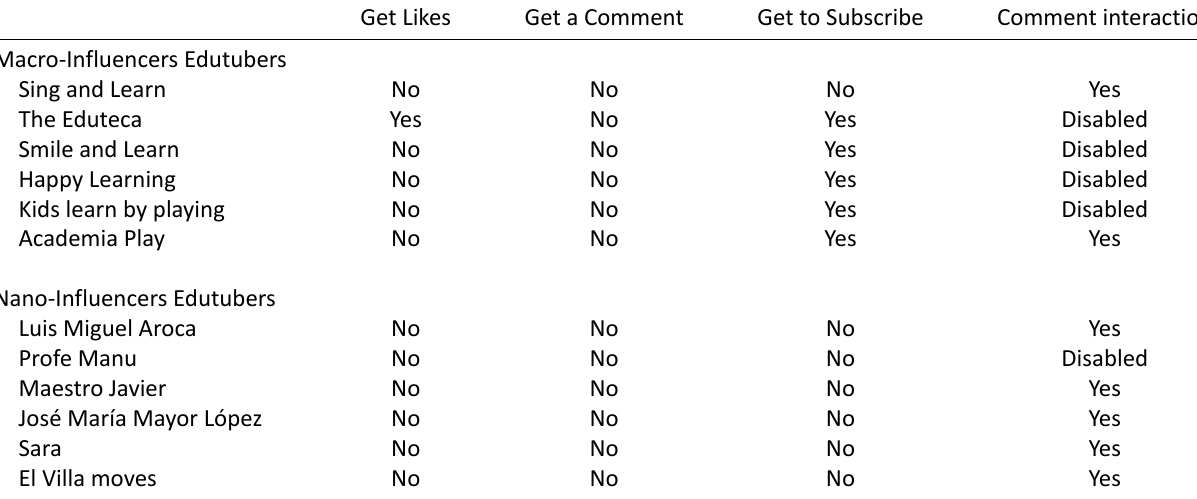
Table 8. Mechanics of interaction on YouTube.